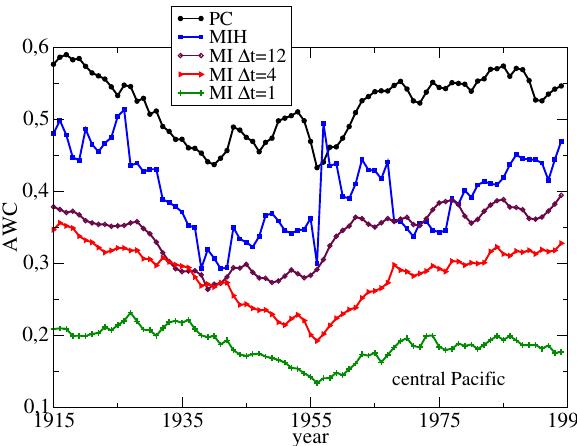
Figure 7. Temporal evolution of the AWC in the CP box. The net- works are built by evaluating 30-year windows of the 200mb eddy geopotential height field (NOAA) with every methodology used in this work. For each mean AWC value the time periods corresponding to 15 years before and 15 years after were